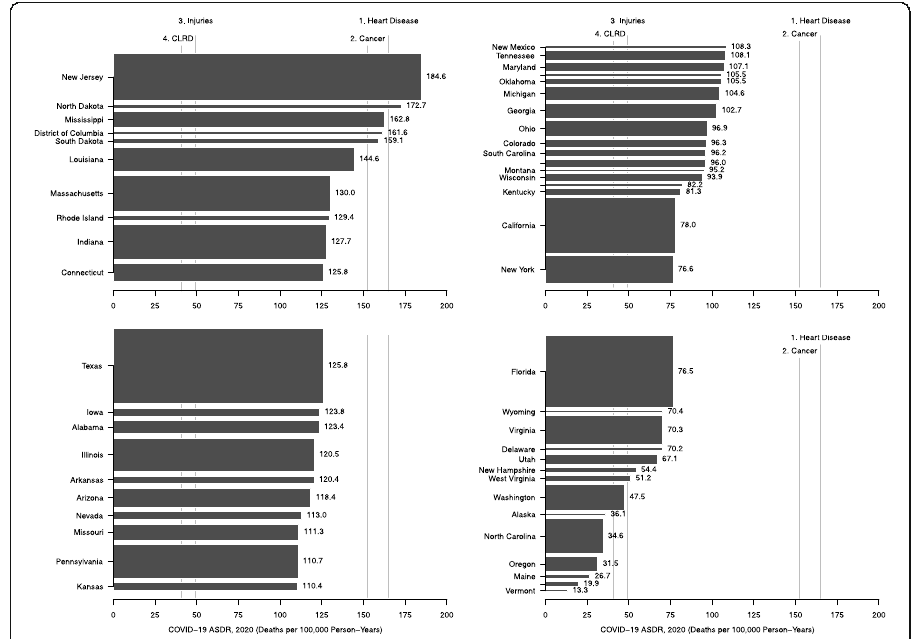
Fig. 4 Age-standardized death rate from COVID-19 in the US. Source: authors ’ calculations. Note: the height of each rectangle is proportional to the population size of each